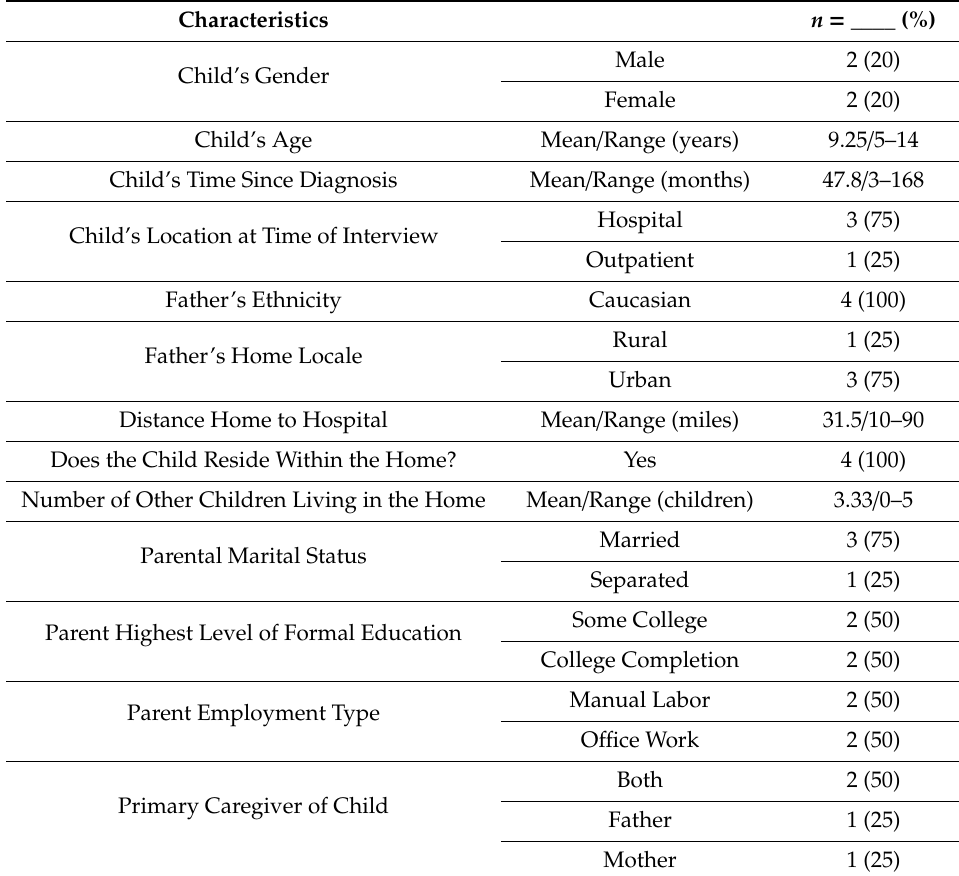
Table 1. Participant